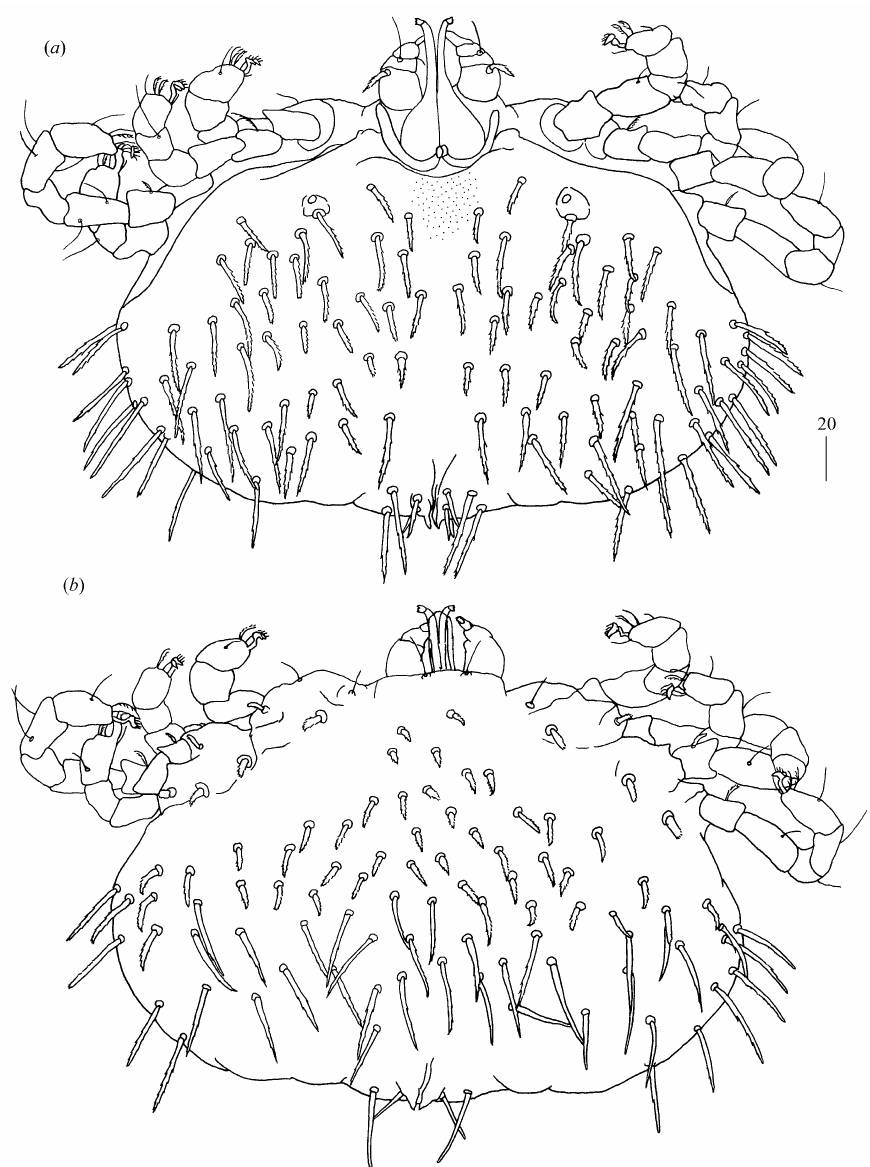
Figure 18. Geckobia indica Hirst, 1917 deutonymph: ( a ) in dorsal view; ( b ) in ventral view. Deutonymph (range for two specimens). Chelicerae 70–75 long. Swollen cheliceral part 30–35 long and slender distal part about 40 long. Fixed cheliceral digit spinous and 5 long. Setae dG filiform and smooth, 35 long; setae dF slightly serrate and 20 long. Each branch of peritremes 45 long. Idiosoma 220–255 long and 320–330 wide. Dorsum (Figure 18a) propodonotal shield (about 90 wide and 65 long) weakly outlined, with minute punctations in anterior part and five serrate setae, 20–35 long. Laterally to propodonotal shield, small platelets (15 long and 15 wide) with eye and one pair of serrate setae about 20 long present. Posterior to propodonotal shield short plumose setae (about 15 long) present in medial part of idiosoma. These setae increase in size from medial to posterior and lateral parts of idiosoma, 20–40 long. Venter (Figure 18b) with about 35 short plumose setae in antero-medial part (10–30 long) and about 45 longer serrate setae (40–70 long) in posterior part. Genital setae series represented by three pairs of slightly serrate setae g1–g3 25, 20 and 15 long, respectively. Setae ps1–ps3 serrate and 45, 40 and 25 long, respectively. Legs as in